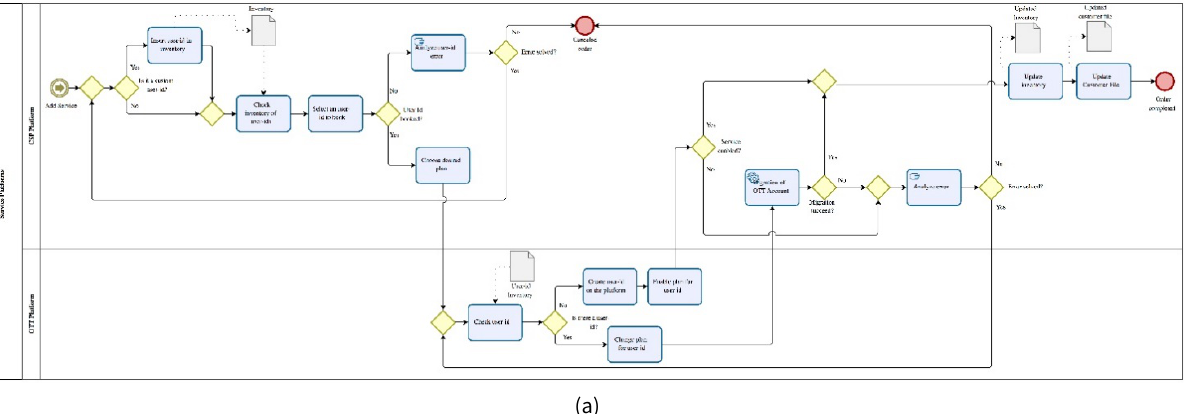
Figure 5. Level 4 - “Order-to-Payment” Service Processes (Level 4): (a) Add Service; (b) Change Service; (c) Remove